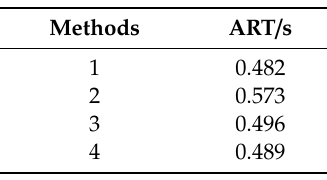
Table 5. ART of di ff erent methods. ‘1’ represents AlexNet, ‘2’ represents VggNet, ‘3’ represents Table 5. ART of different methods. ‘1’ represents AlexNet, ‘2’ represents VggNet, ‘3’ represents Inception-V3, and ‘4’ represents improved R-FCN. Inception-V3, and ‘4’ represents improved R-FCN.